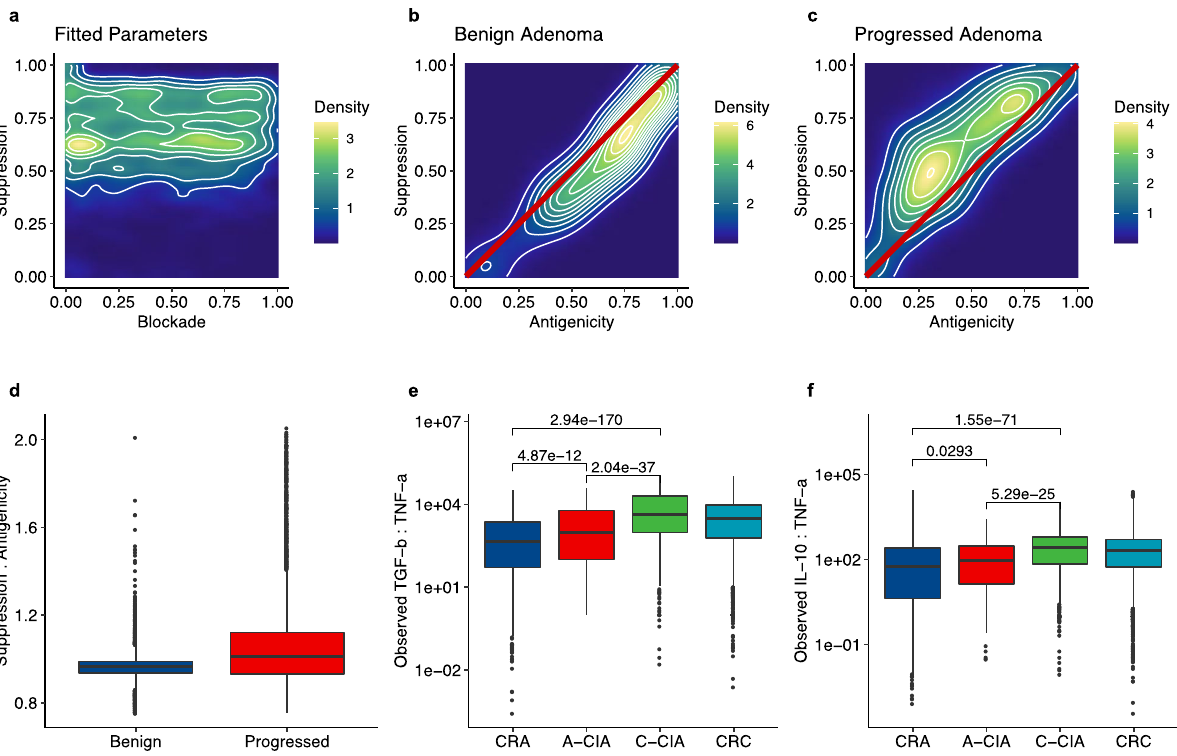
Fig. 9 An accept/reject statistical inference method was used to determine which model parameters could recreate the observation that benign adenomas (CRA) were more immunogenic and also had more immunosuppressive cells than progressed adenomas (A-CIA). a Heatmap showing the number of times each combination of Blockade ( ϕ ) and Suppression ( σ ) produced a benign CRA that had higher antigenicity, more immune suppression, and more immune blockade than A-CIA using that same parameter combination. The narrow range of high suppression values (0.583 – 0.83, 25th and 75th percentiles, respectively), and wide range of immune blockade values (0.167 – 0.71, 25th and 75th percentiles, respectively), suggests that, in colorectal cancer, immune suppression is strong, and the effect of the blockade is minimal, as there is no clear gradient along the Blockade axis. b , c Heatmaps showing the relationship between antigenicity and immune suppression of simulated benign and progressed adenomas that fi t the data, with the red line showing a 1:1 relationship. For any given antigenicity, simulated progressed adenomas have more immune suppression compared to benign adenomas. d Ratio of suppression to antigenicity in benign and progressed adenomas in the 8,571 simulations that fi t the data. Progressed adenomas ’ higher ratio allows them to effectively reduce immune predation. e , f Observed spatial ratios of immunosuppressive cytokines (TGF- β , IL-10) to in fl ammatory cytokines (TNF- α ), based on marker abundances within each samples ’ quadrats ( n = 9 independent CRA, n = 9 independent CIA (A-CIA and C-CIA), and n = 9 independent colorectal carcinomas (CRC)). Dunn ’ s test was used to calculate the unadjusted p-values. As predicted by modeling, compared to benign adenomas (CRA), progressed adenomas (A-CIA) have signi fi cantly higher ratios of immunosuppressive cytokines to in fl ammatory cytokines. While the effects of cytokines may not be equal, these results suggest that the effect of immune suppression will be greater in progressed adenomas than in benign adenomas. In d – f , the center line of each boxplot indicates the median, the top and bottom of the box indicate the 75th and 25th percentiles, respectively, the top whisker the largest value that is no further than 1.5 interquartile range (IQR) from the 75th percentile, the bottom whisker the smallest value no more than 1.5 IQR from the 25th percentile, and points indicate